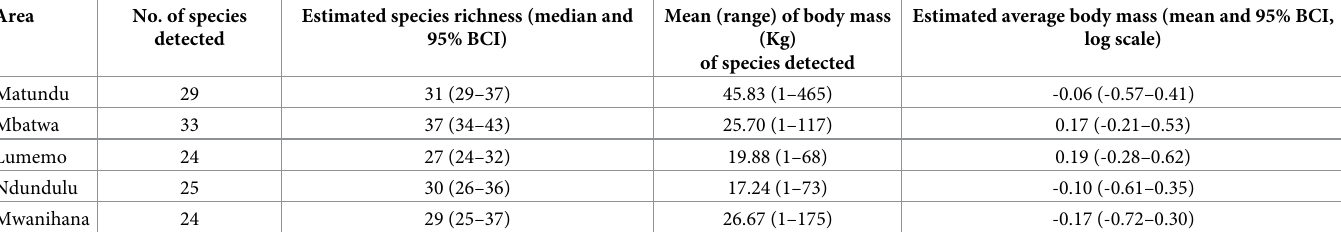
Table 3. Area-specific data and model results for species richness and body mass. Summaries of species richness, estimated richness, body mass of species detected and average estimated body mass for communities of mammals sampled by camera traps in five areas in the Udzungwa Mountains of Tanzania.